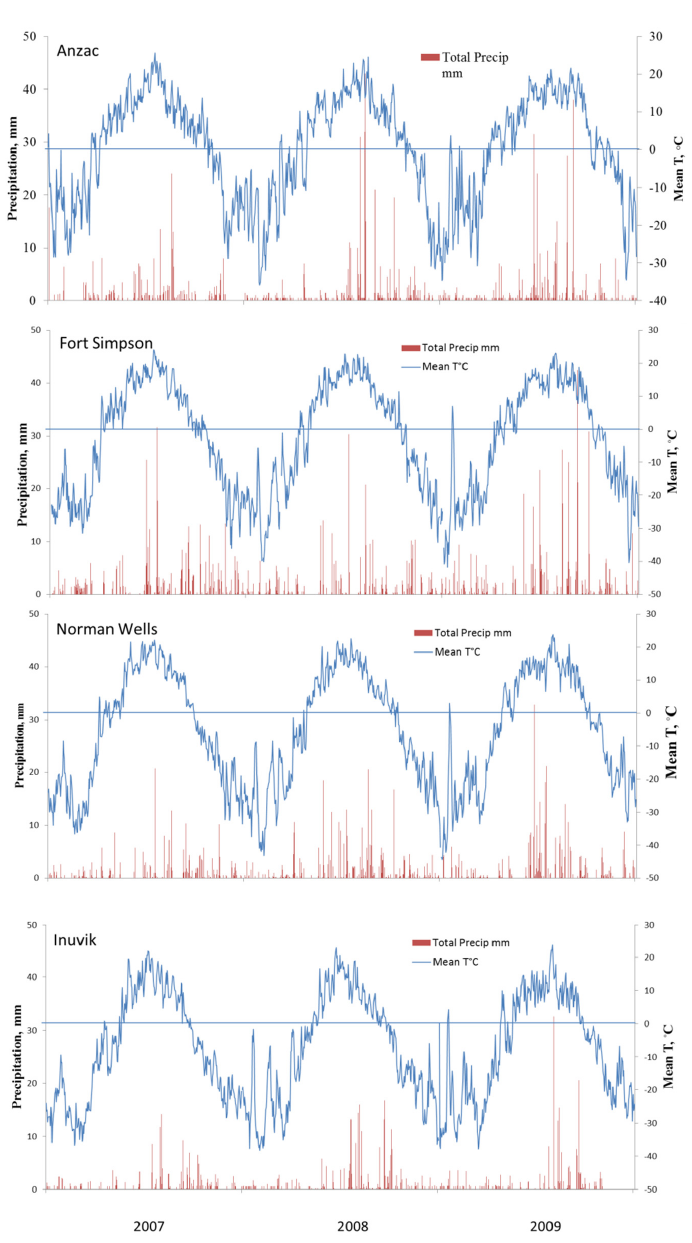
Figure 3. Seasonal patterns of soil temperature ( T s ) and precipitation ( Ppt ) during the three year period at Anzac (AB), Fort Simpson (NWT), Norman Wells (NWT) and Inuvik (NWT). at Anzac (AB), Fort Simpson (NWT), Norman Wells (NWT) and Inuvik